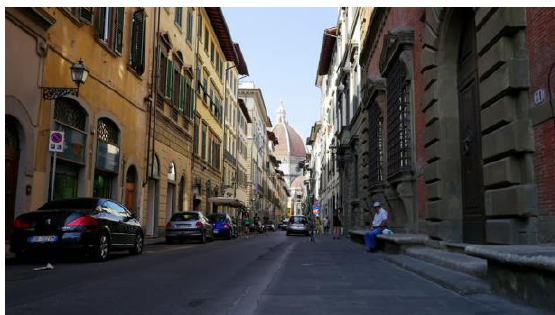
Figure 13. Directionality representing spatial